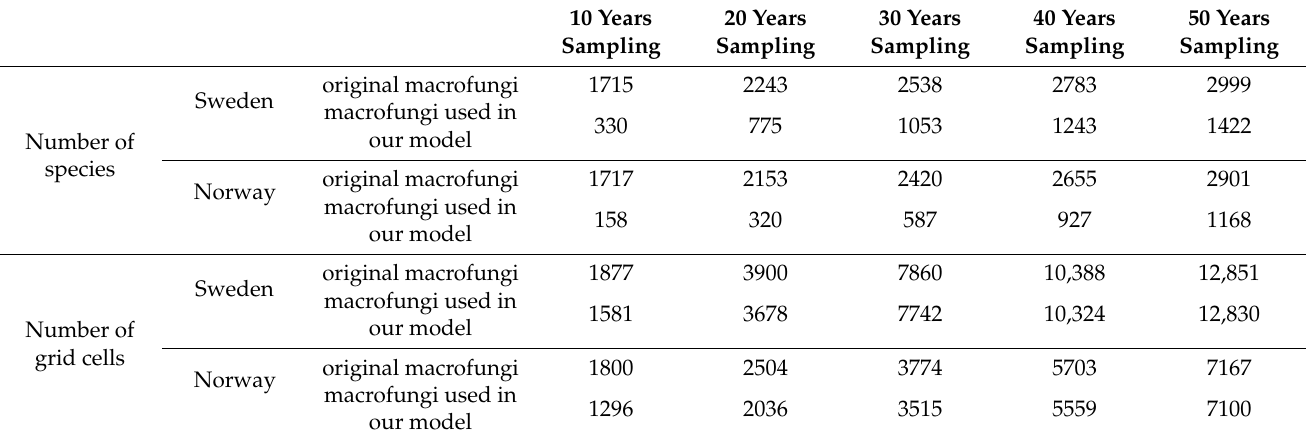
Table 1. The number of species and the number of grid cells in the original macrofungal database and the final macrofungal occurrence data used in our model for each sampling period and each